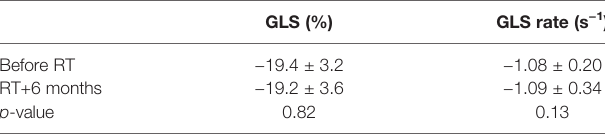
TABLE 4 | Global longitudinal strain and strain rate parameters before RT and at RT+6